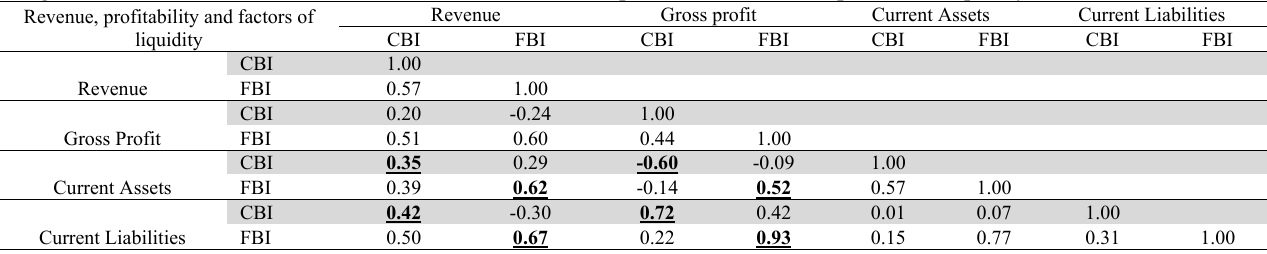
Long-term and short-term cohesiveness between revenue, net profit and factors of operational liquidity Revenue, profitability and factors of